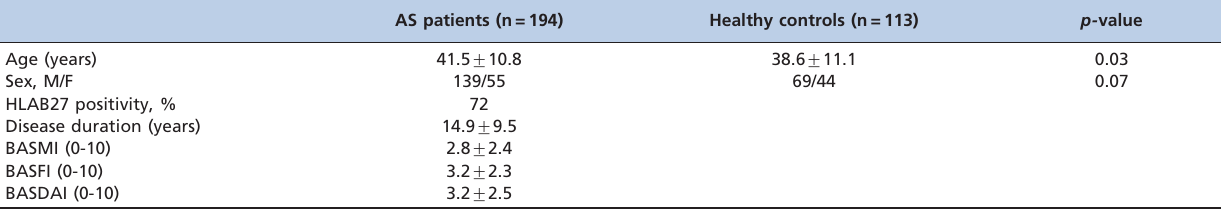
Table 1 - Clinical and demographic characteristics of the patients and controls. AS patients (n=194)